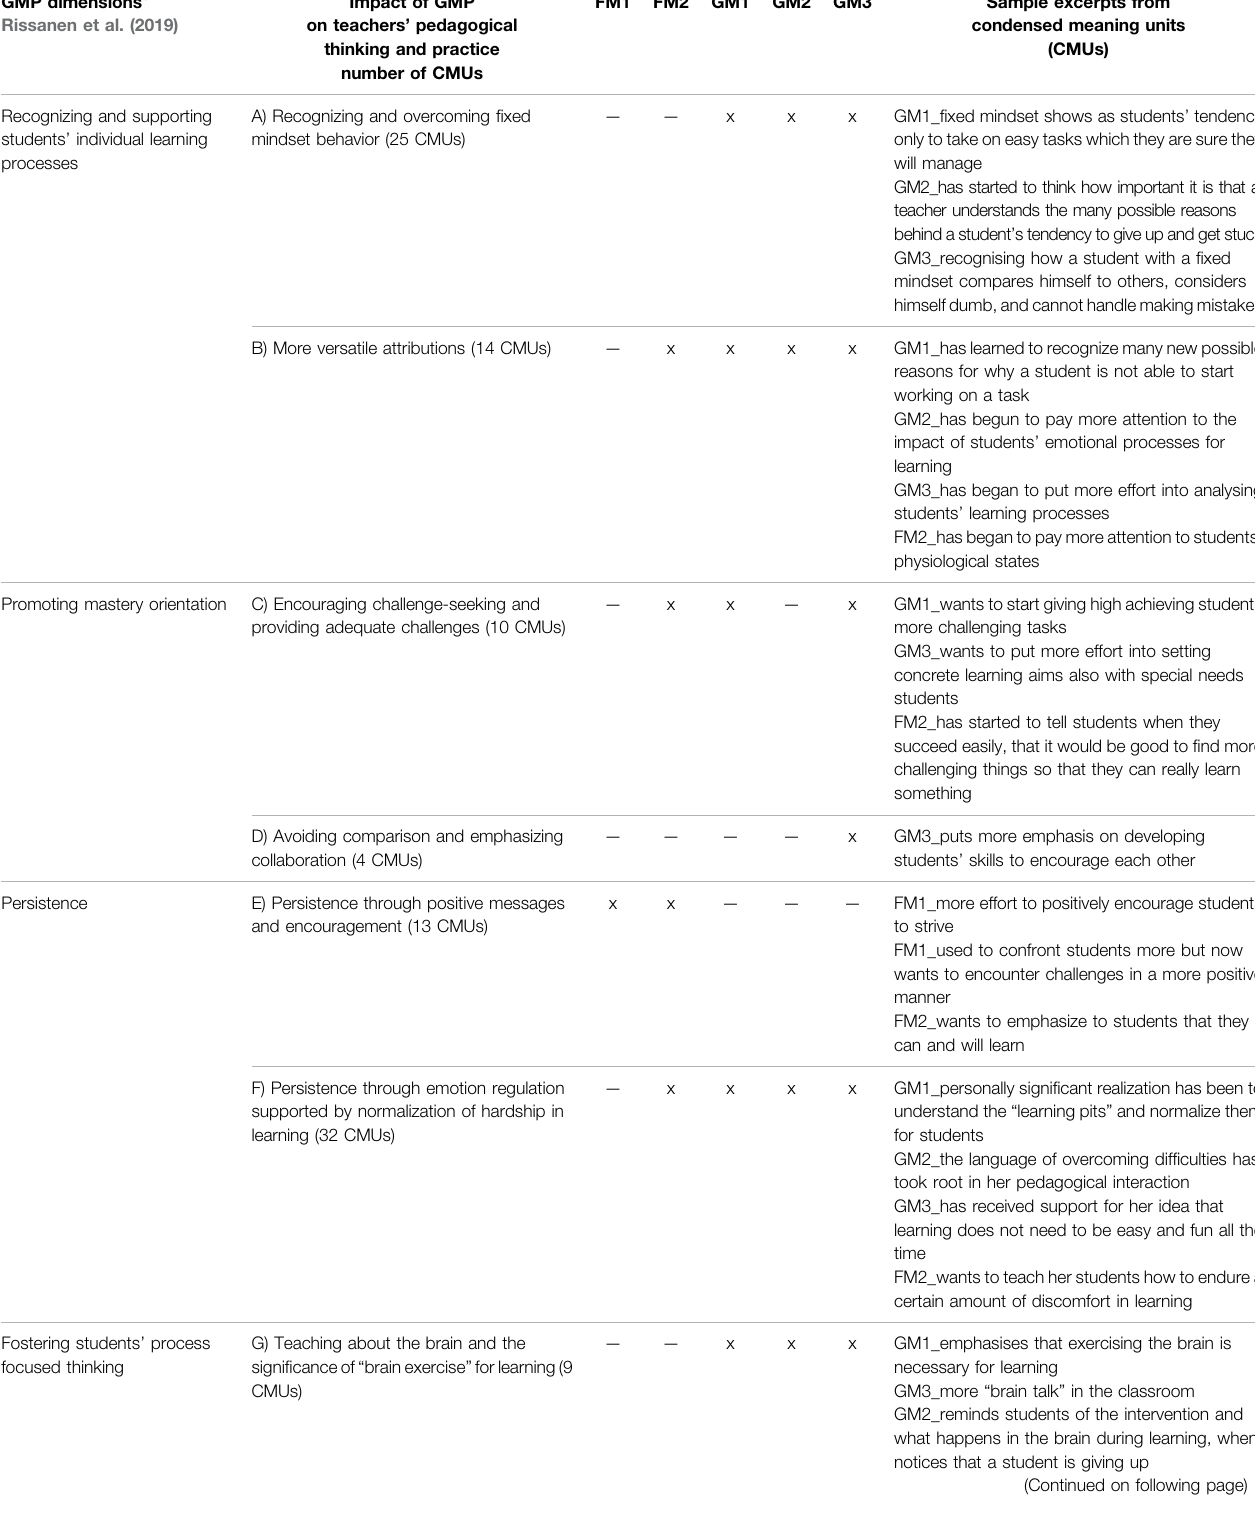
TABLE 3 | Teachers ’ perceptions of the impact of GMP on their pedagogical thinking and